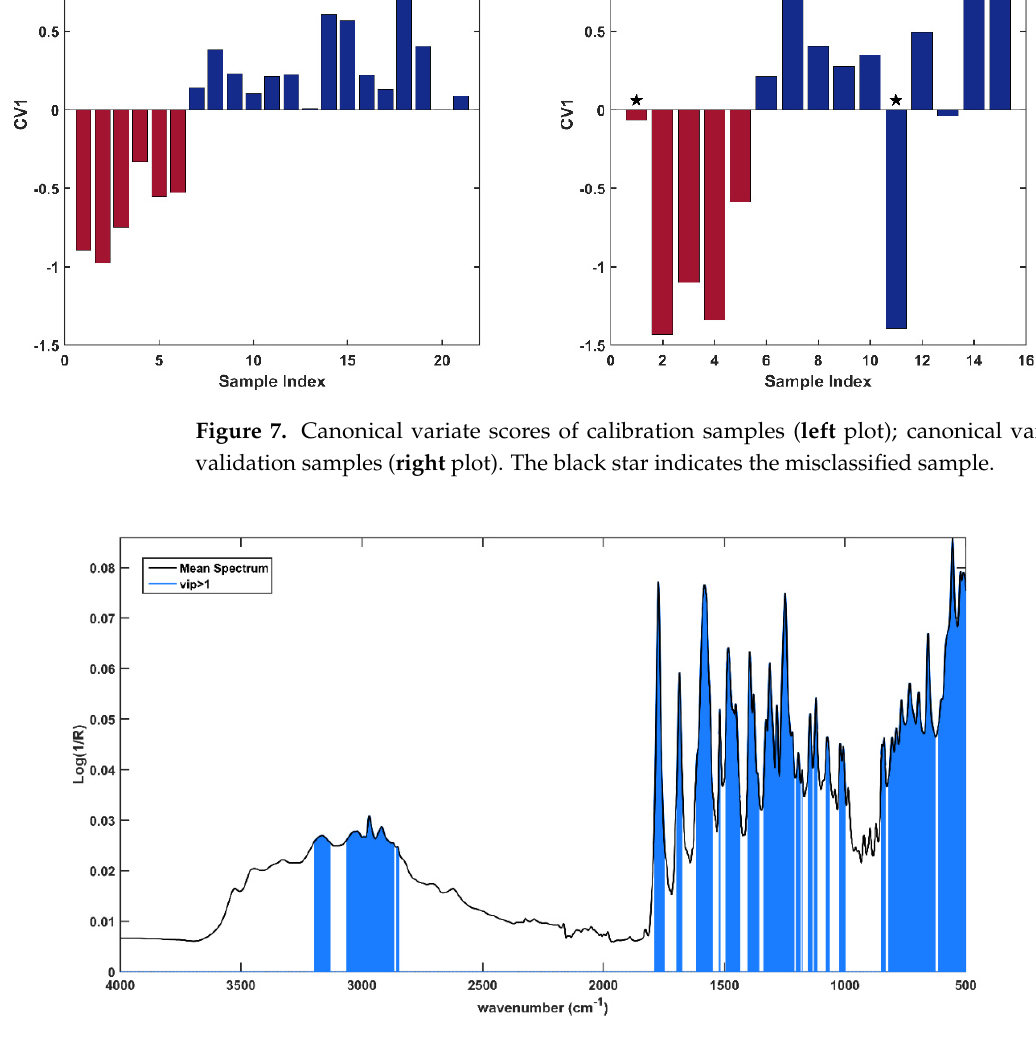
Figure 8. Average spectrum collected on the ground tablets. Spectral variables presenting vip > 1 are highlighted in light blue.